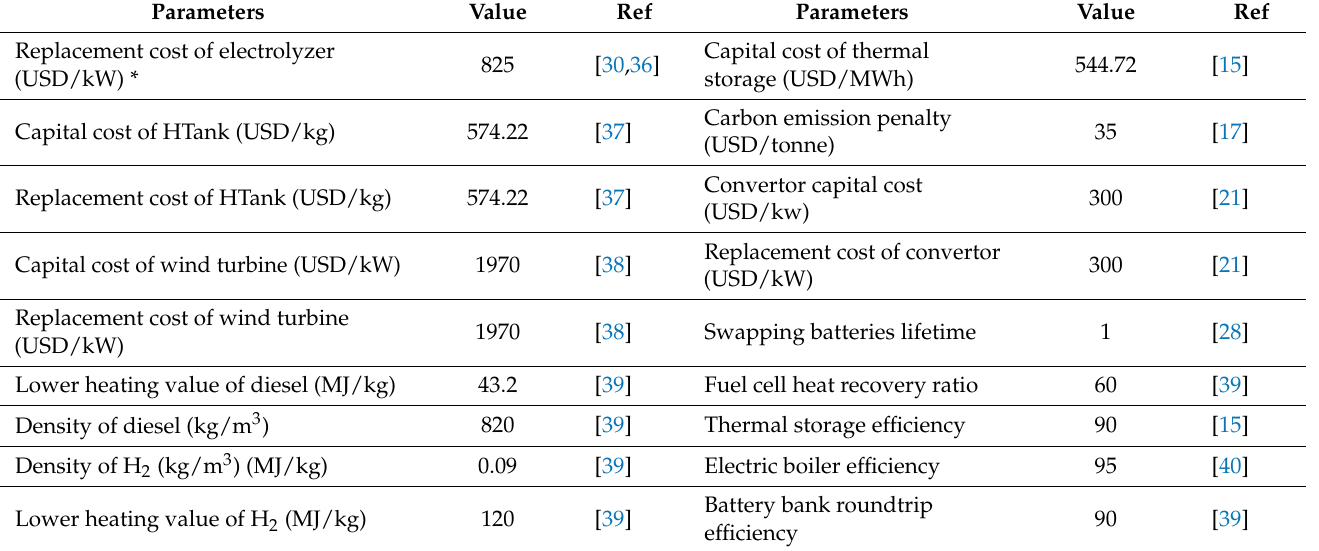
Figure 10. The site’s modular size scale heating demands for minimal and intensive C&MP scenarios. 3.2. Main Installations and Corresponding Costs According to the results of the simulations and optimizations conducted in HOMER Pro, coupled with a user-developed analysis tool for each mining scenario, the site will require key equipment installations. Tables 3 and 4 summarize the main equipment in- stallations required at the site for each case and their corresponding levelized cost of en- ergy based on the results generated by the optimization process. According to the results of the evaluation, replacing the mine’s diesel-based power plant with an all-renewable energy system not only reduces the carbon footprint of the operation substantially, but also with a proper design it can give better economic returns when comparing it to a con- ventional diesel-based system. As it can be noted from these tables, for the surface mine with intensive C&MP, employing renewable energy systems makes more financial sense as their levelized cost of energy is lower compared to the minimal C&MP scenario. This cost difference can be traced back to the higher proportion of motive power demand for